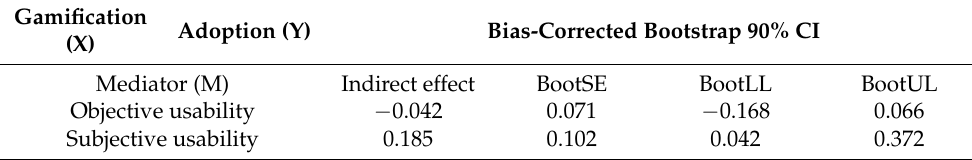
Table 9. Indirect effects of gamification on adoption via objective and subjective usability of in-person counseling.